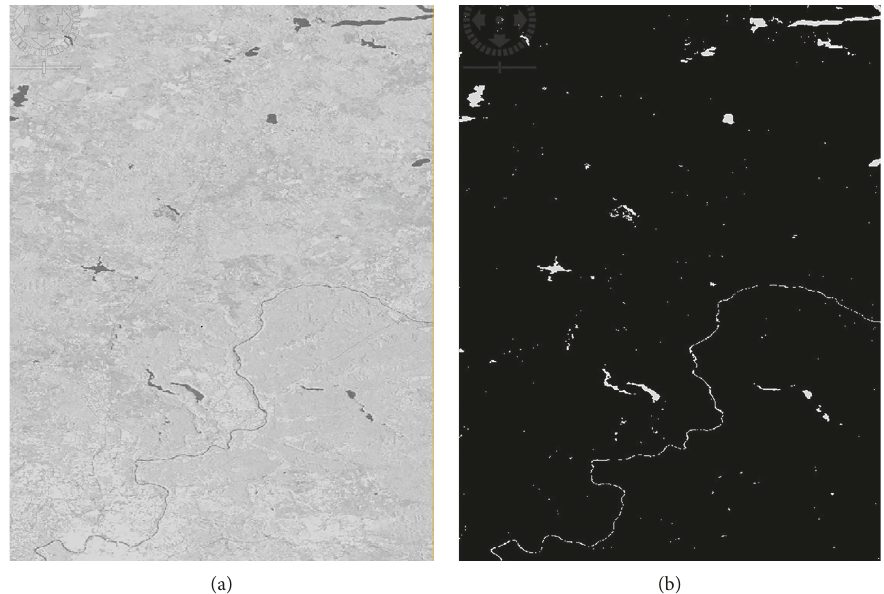
Figure 13: The river channel in the satellite data: (a) band-VV polarization data and (b) new river channel math band (source: